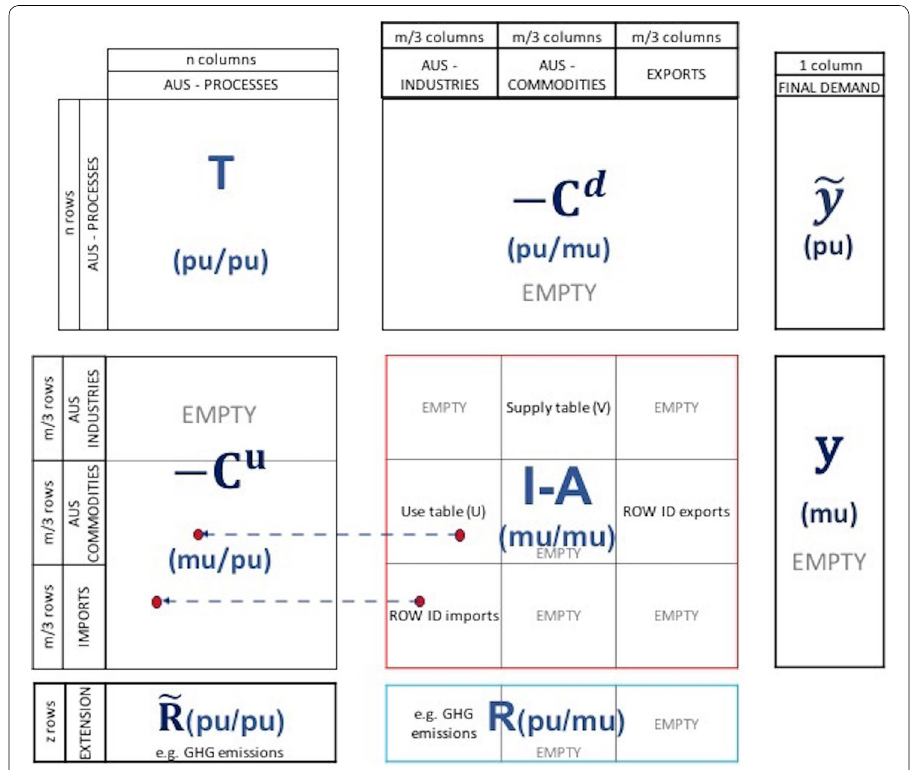
Fig. 1 Structure and main components of the hLCA matrix developed in this study ( pu physical unit; mu monetary unit; ROW rest of world; ID intermediate